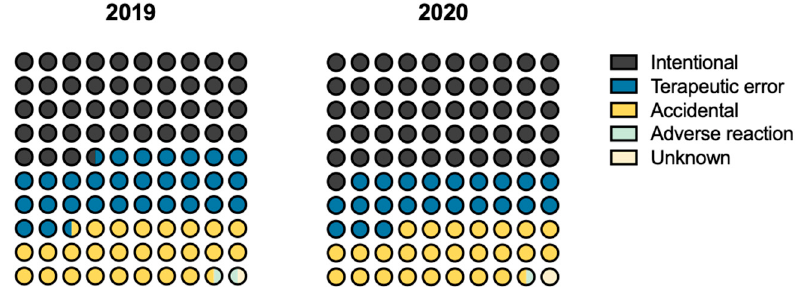
Figure 4. Characterization of the intoxication circumstances in the Algarve region in 2019 and 2020. Comparing 2019 and 2020, the distributions were as follows: intentional (43.47% vs. 51.19%), thera- peutic error (29.11% vs. 21.74%), accidental (25.74% vs. 25.39%), adverse reaction (1.03% vs. 0.84%), unknown (0.65% vs. 0.84%).